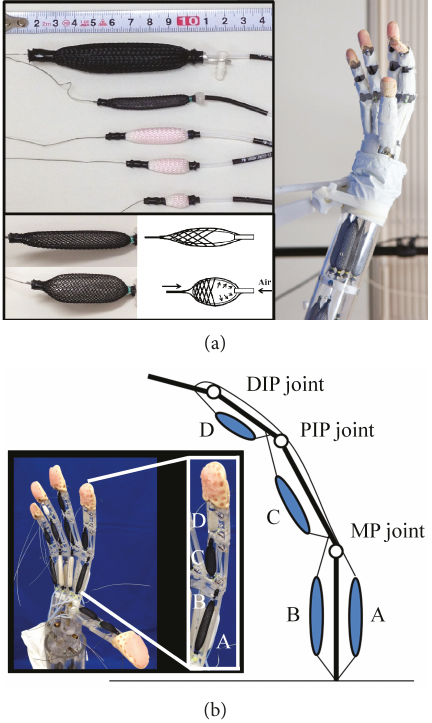
Figure 1: Control target and purpose. (a) Our fi ve- fi ngered robot hand (right photograph) and pneumatic arti fi cial muscles (PAMs) (left photographs) used as the actuator of the robot hand. These muscles are the McKibben actuator made in SQUSE Inc. and are driven by supplied compressed air (bottom-left pictures). (b) The structure of the index fi nger of the robot hand (the image and the closed photograph in the inset). The position of the tip of the index fi nger is controlled as a musculoskeletal robot. Various muscle lengths shown in (a) are arranged on the links of the index fi nger (they are also arranged for other fi ngers). The muscles A and B are of the same length. The muscle C is shorter than muscle A or B, and the muscle D is the shortest of all muscles on the fi nger. Each joint is driven from 0 deg (maximum extended state) to 90 deg (maximum fl exed